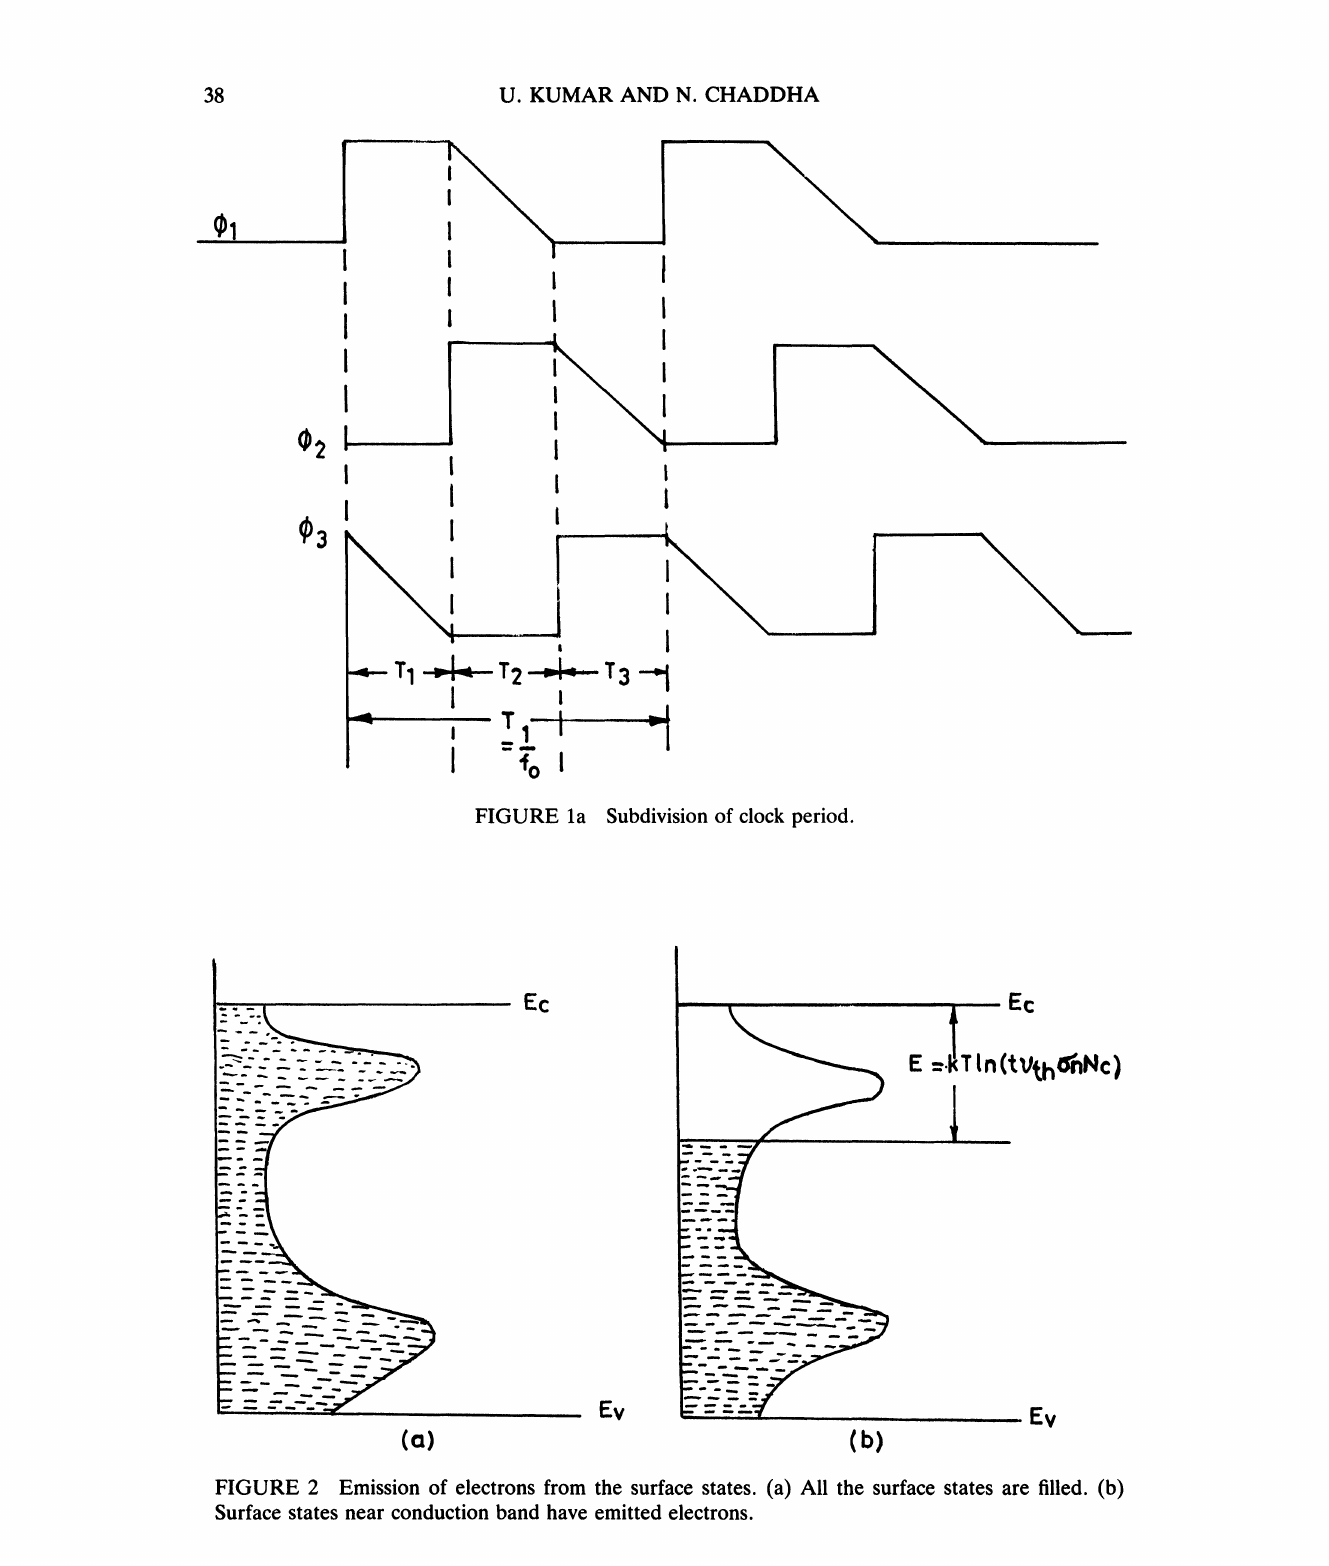
FIGURE 2 Emission of electrons from the surface states. (a) All the surface states are filled. (b) Surface states near conduction band have emitted